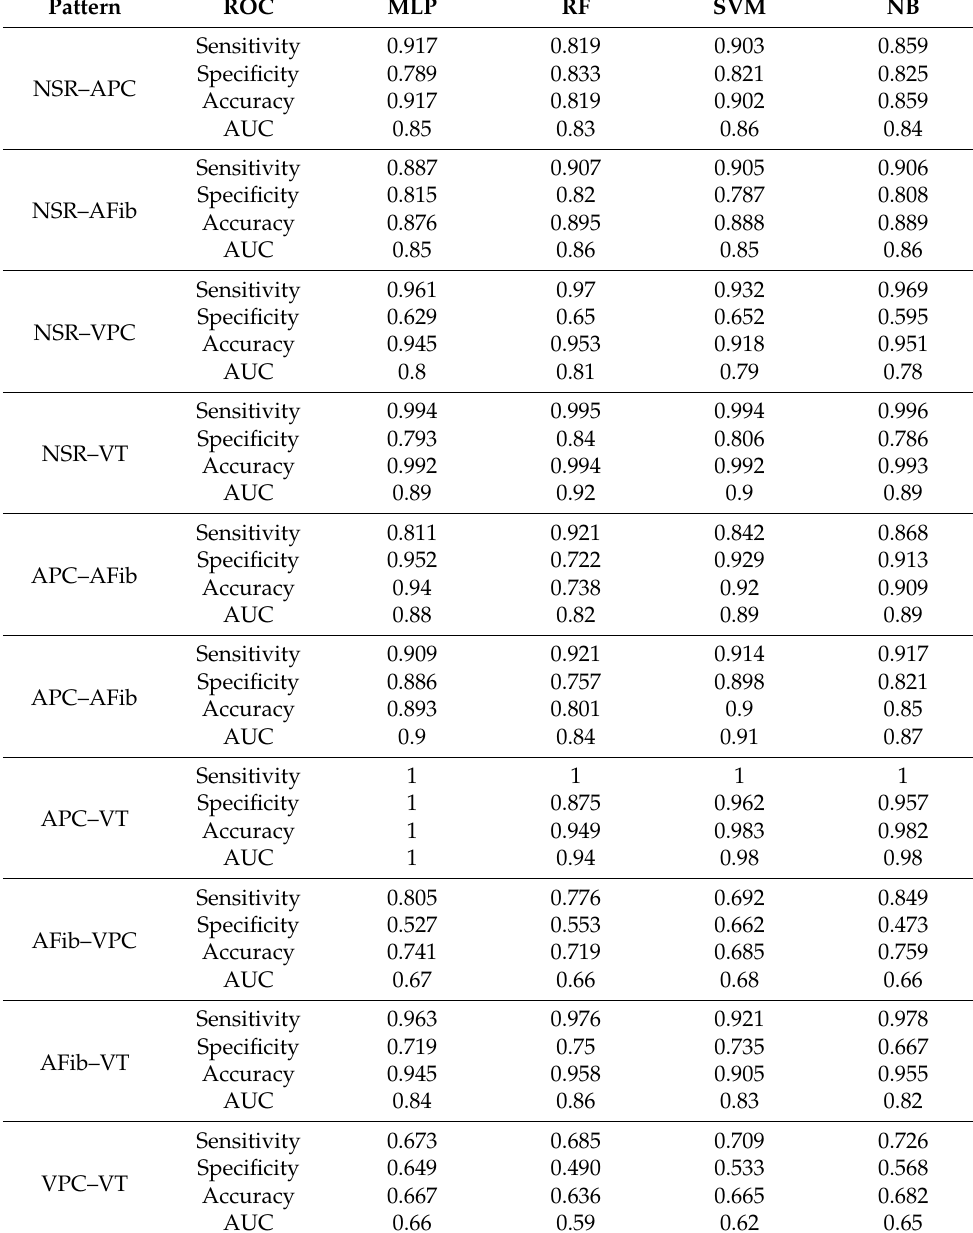
Table 4. Evaluation of the ML models for the patterns of hybrid symptoms due to the training the data set (C) and testing the data set (B), which the pattern labeled by two symptoms (e.g., NSR–APC means normal sinus rhythm versus atrial premature atrial complex) presents their ROC’s results due to the four models (i.e., multiple layer perceptron, random forest, support vector machine, and naïve Bayes models) for